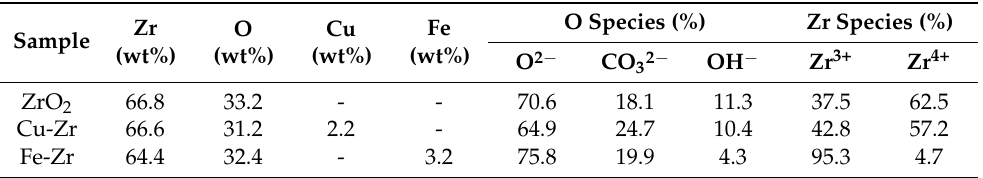
Table 2. Elemental composition of ZrO 2 , Cu-Zr calcined catalyst and Fe-Zr calcined catalyst from XPS